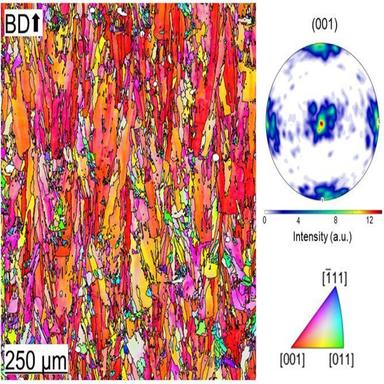
EBSD micrograph of the A9Z2 alloy in the heat-treated and undeformed state including the pole figure and the invers pole figure in the build direction. For colors, please see digital version.